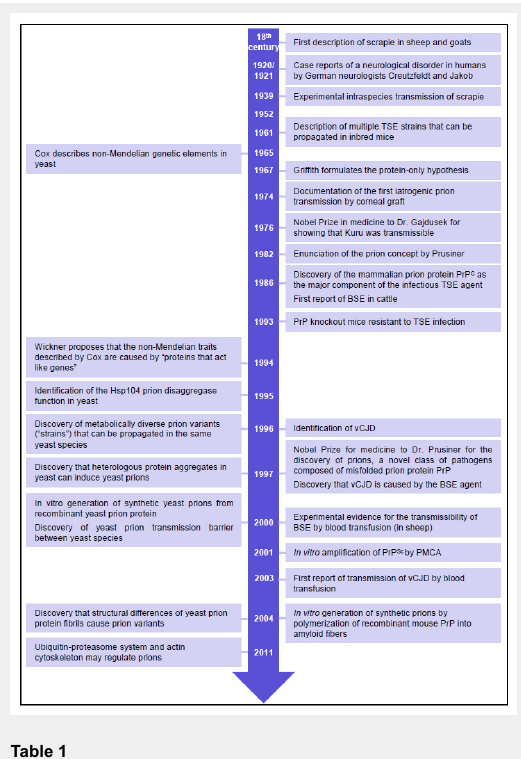
Timeline of important discoveries in mammalian and yeast prion